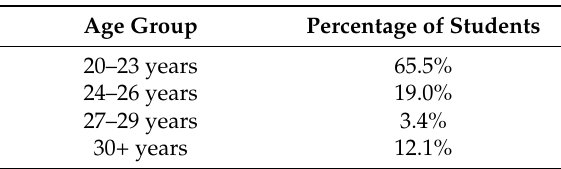
Table 2. The ages of respondents.